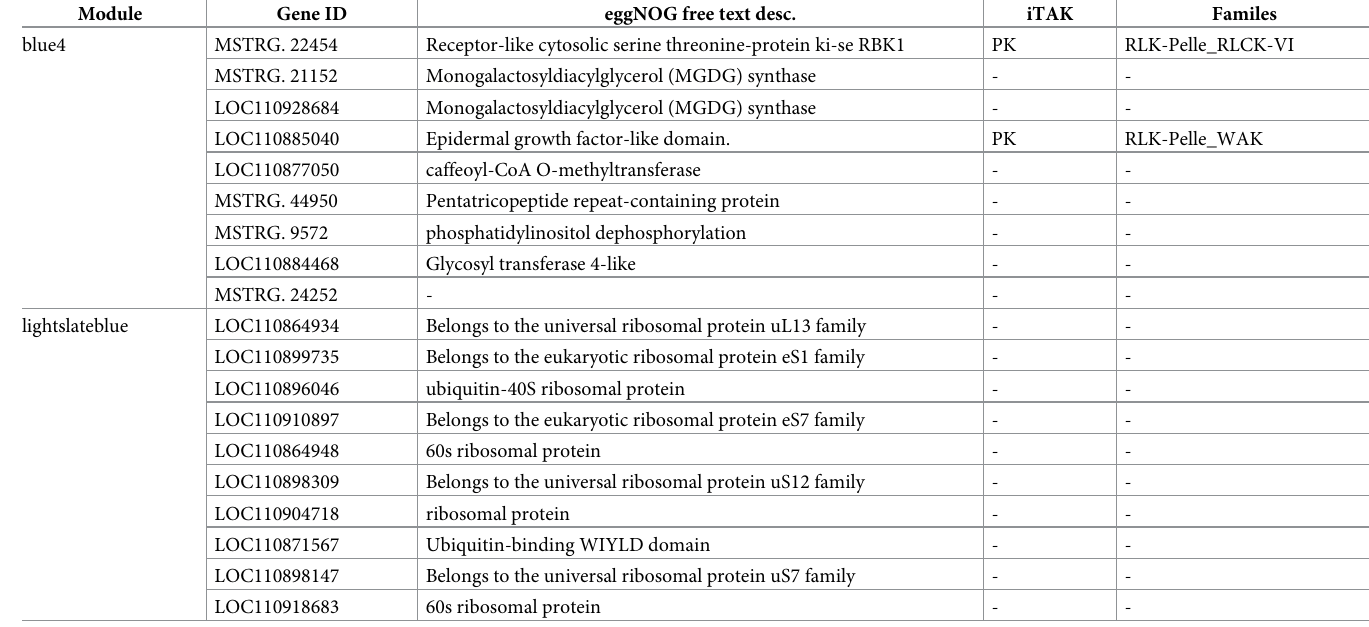
Discussion Sunflower is an economically important oilseed crop and shared 9% of the world oilseed mar- ket [48]. It is considered a medium drought-resistant crop, and with the extension of cultiva- tion to arid areas, drought has become one of the most important factors affecting its yield Table 2. Annotaions of top 10 genes ranked by MCC algorithm. Module Gene ID eggNOG free text